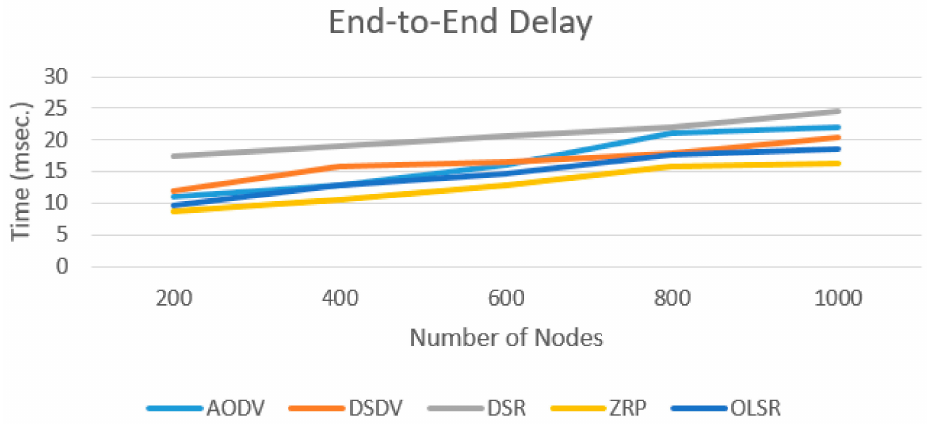
Figure 4. Comparative analysis of end-to-end delay in 200–1000-node networks using the proposed scheme over five MANET routing